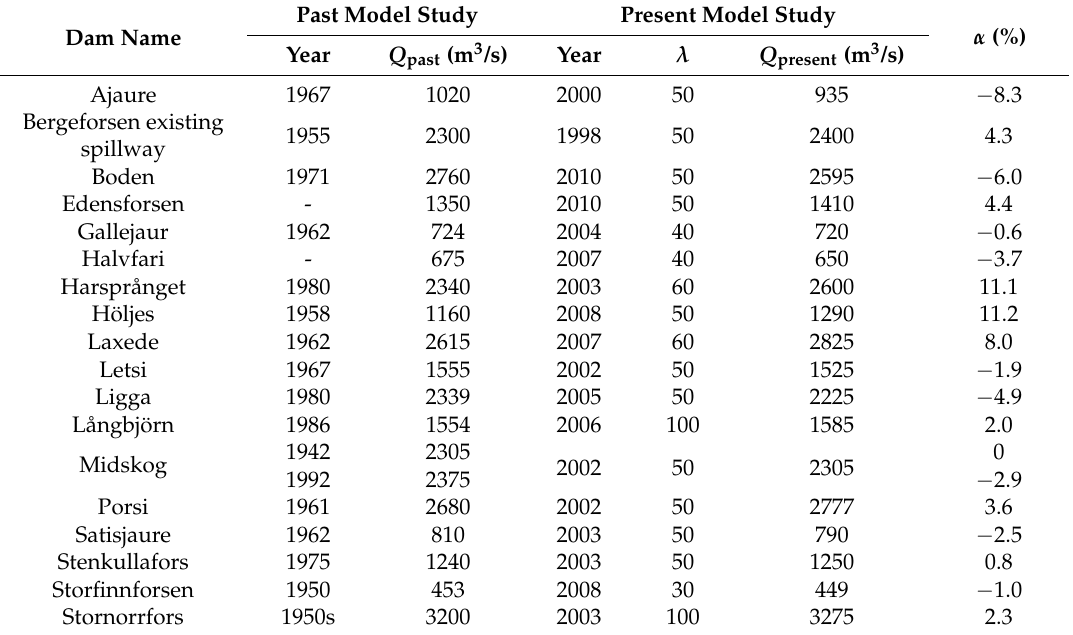
Table 4. Spillway discharges from the past and renewed physical model